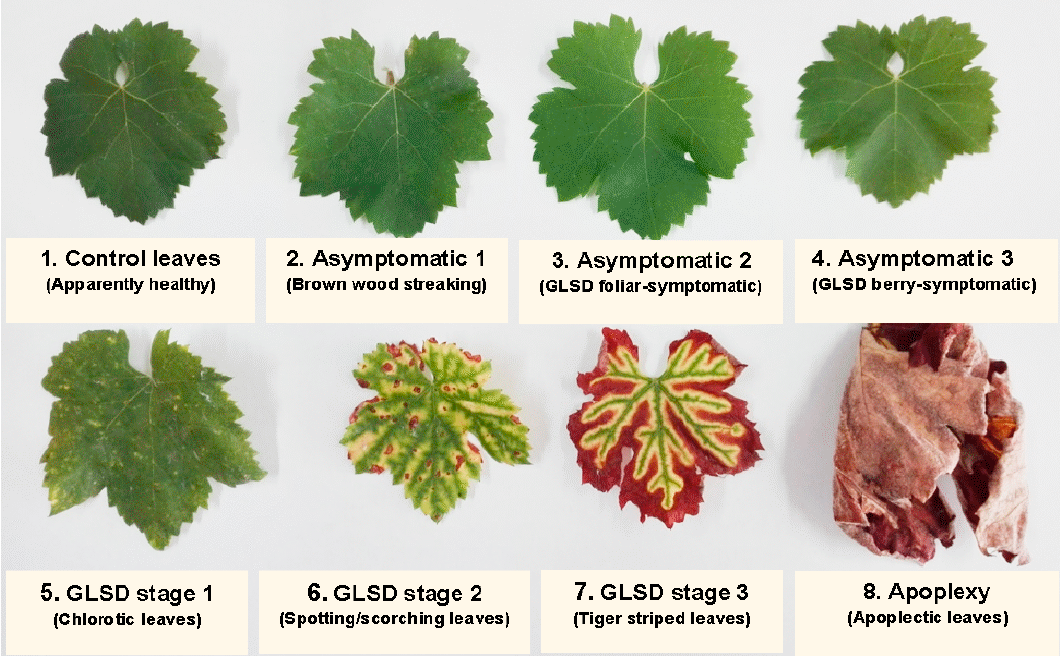
Figure 6. Description of the sampling procedure: A view of the foliar morphology of asymptomatic and symptomatic leaves of Vitis vinifera L. ‘Malvasia’ affected by brown wood streaking, grapevine leaf stripe (GLSD) and apoplexy.